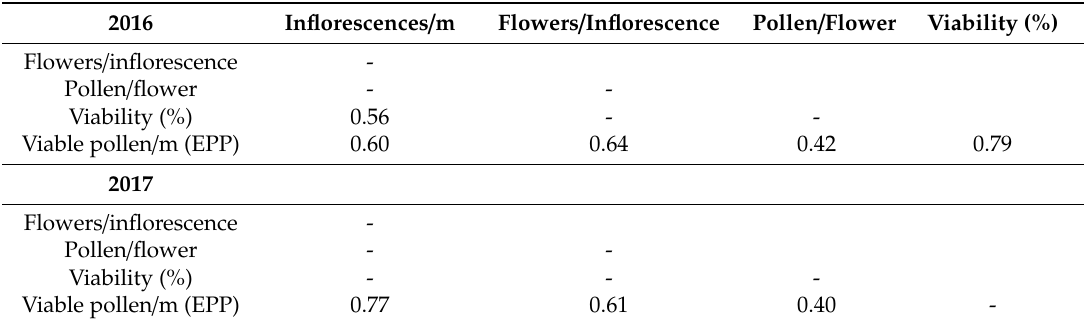
Table 3. Correlation matrixes highlighting significant correlations ( R -values) between properties within genotypes in 2016 and 2017 ( n = 11). 2016 Inflorescences / m Flowers / Inflorescence Pollen / Flower Viability